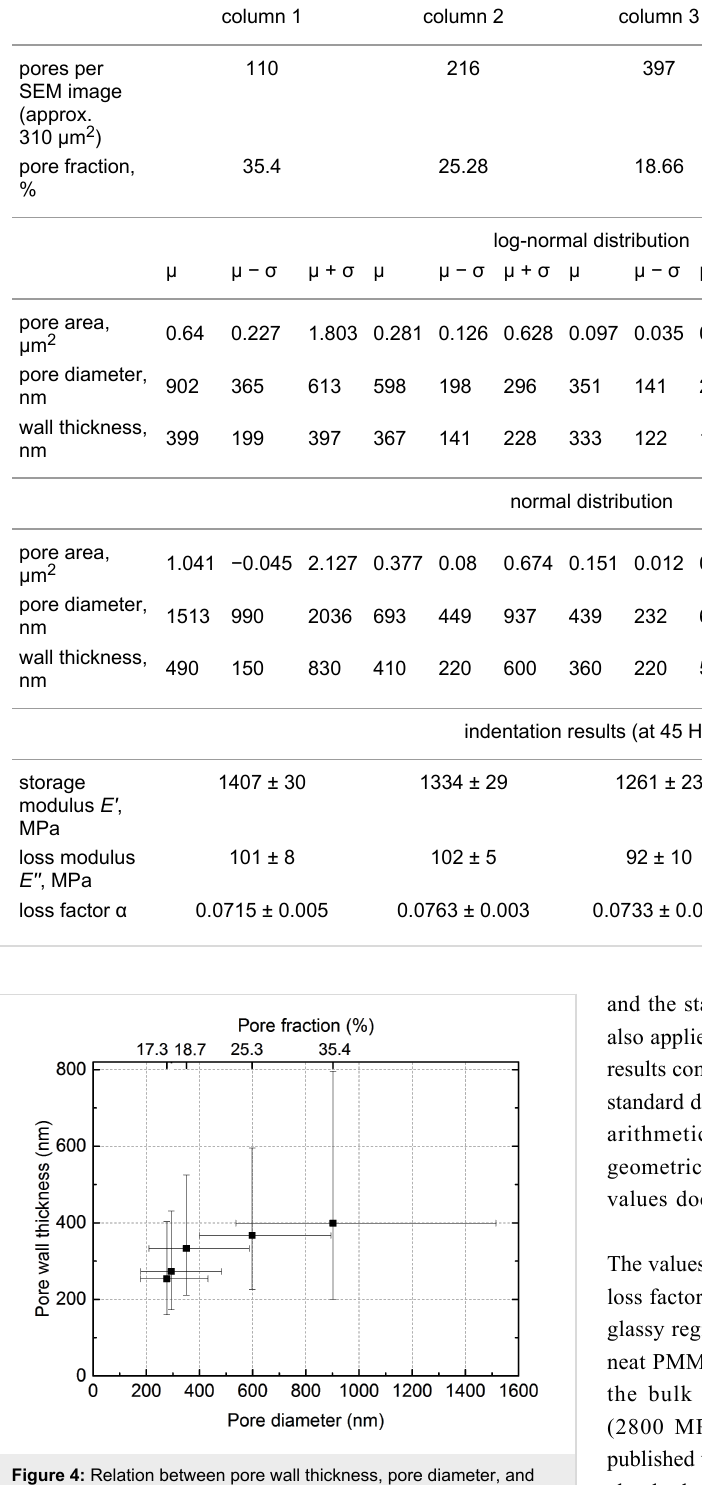
Table 1: Properties of the porous PMMA. Pore area, diameter and wall thickness for the indentation columns 1–5, fitted both with log-normal and normal statistical models, and corresponding size-dependent values of storage modulus E' , loss modulus E'' and size-independent loss factor α . column 1 column 2 column 3 column 4 column 5